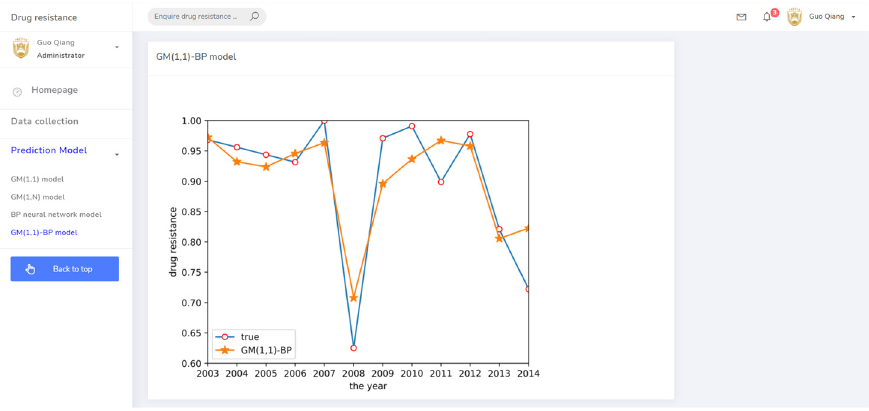
Figure 11. The prediction system page for the GM(1,1)-BP model.